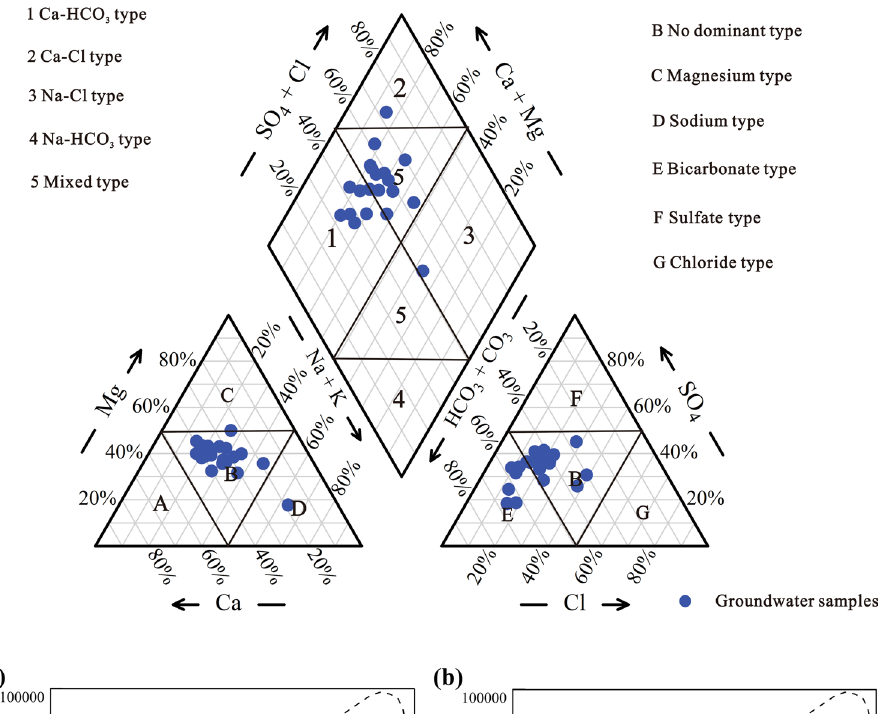
Fig. 4 Gibbs diagrams of groundwater